Question: Summarize what this figure shows in one sentence.
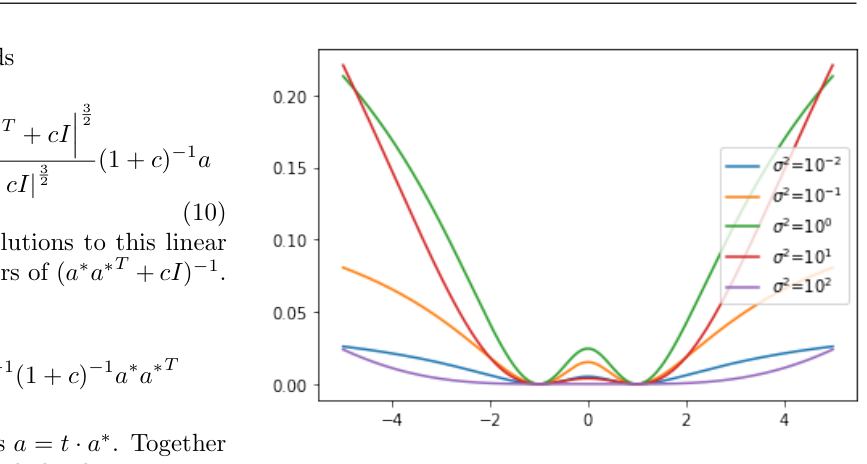
Answer: MMD loss of Gaussian over R with unknown covariance, different widths σ2 and a∗= 1.